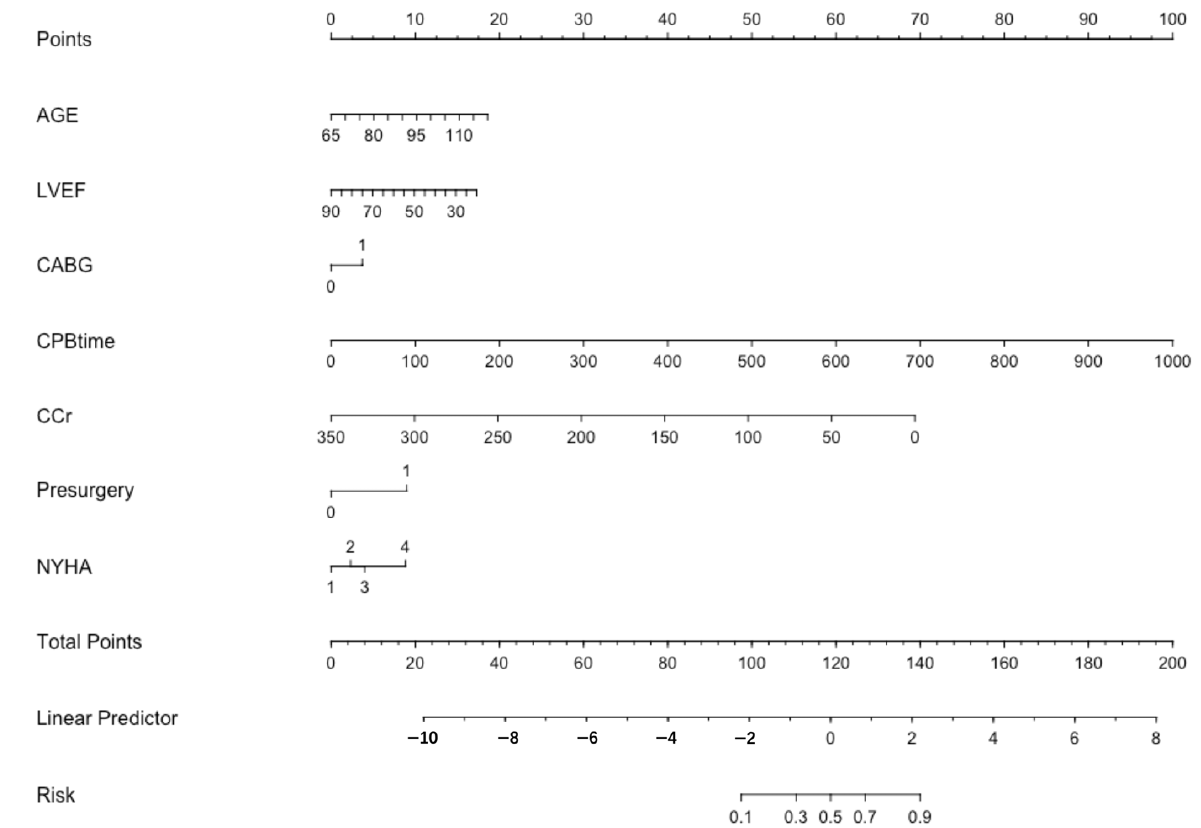
Figure 6. Nomogram prediction model of in-hospital mortality for elderly patients undergoing cardiac valvular surgery. Each variable corresponds to a risk score, and the total score is obtained by summing all scores to the corresponding risk of mortality.